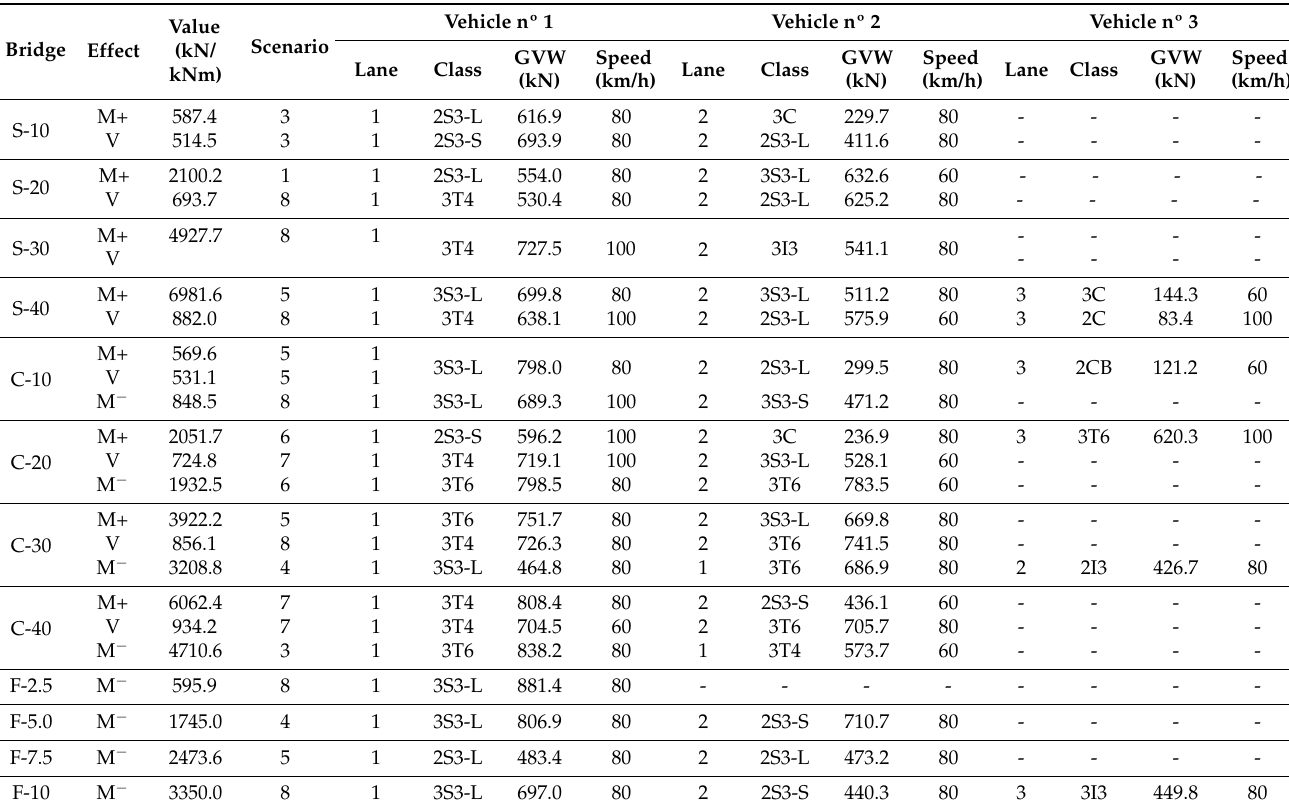
Table 5. Vehicle configurations that generated the extreme static effects on the